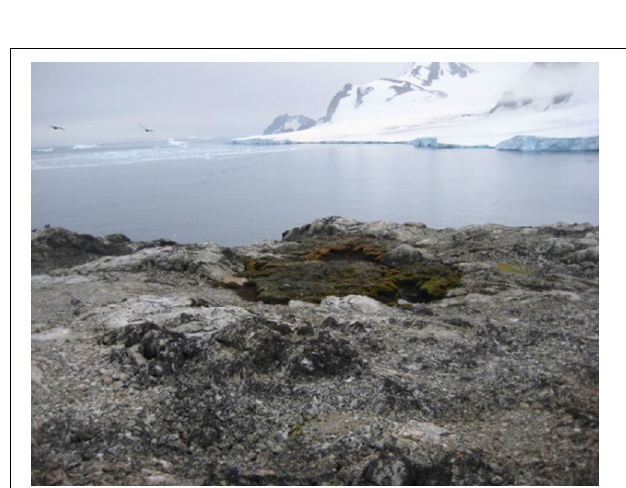
FIGURE 10 | The southern limit of flowering plants and peat growth at Lazarev Bay, north west of Alexander Island (69 ◦ 22.0’s; Convey et al., 2011).